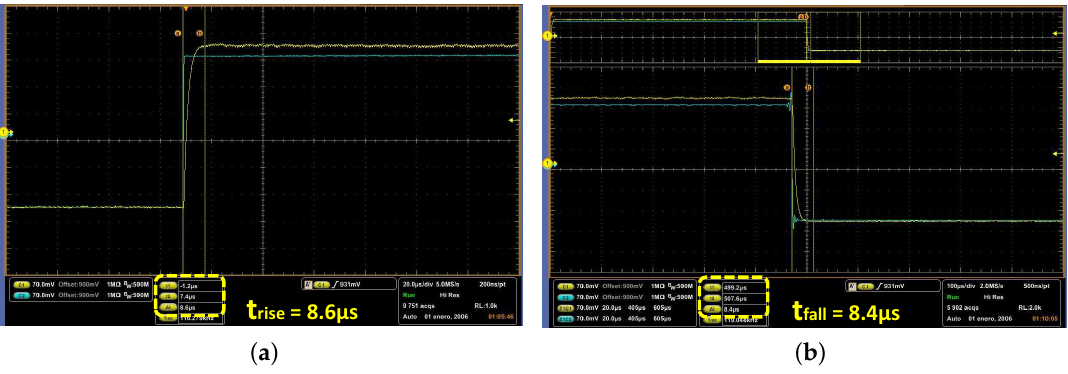
Figure 15. Response of the integrated prototype to an input current step: ( a ) rising edge; and ( b ) falling